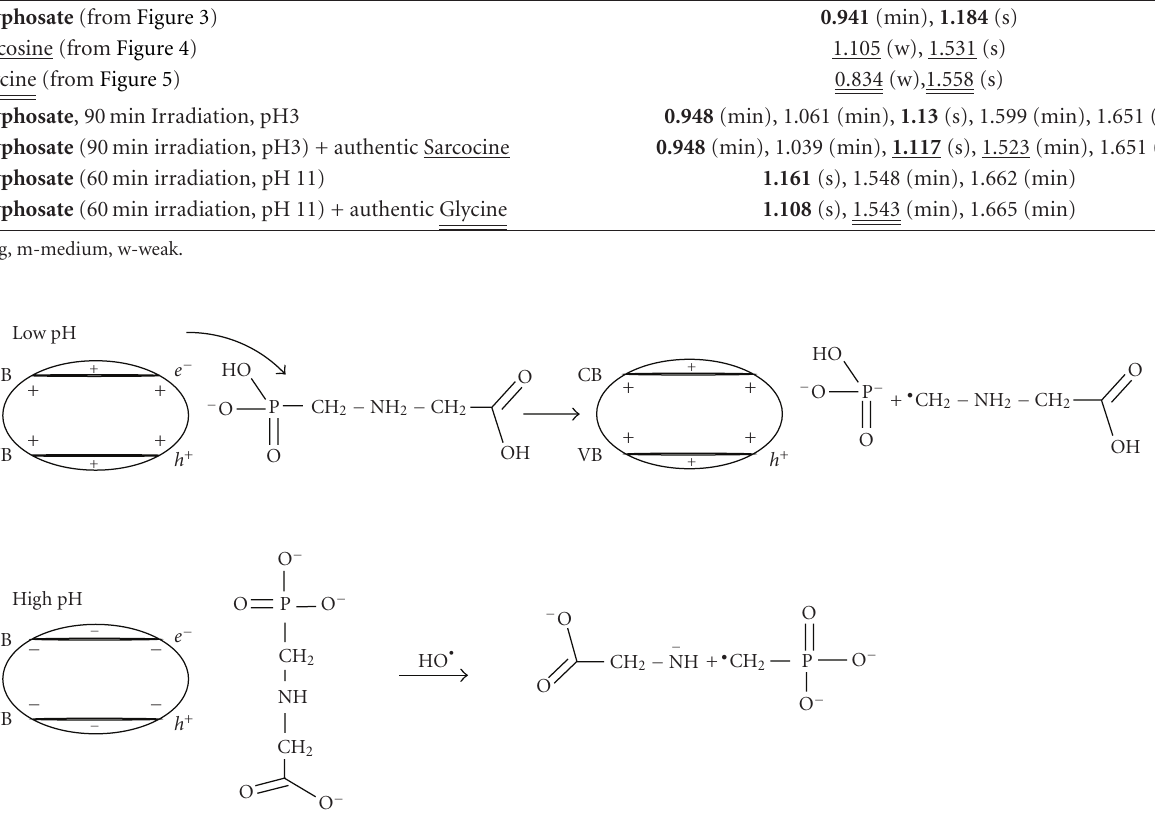
Figure 6: The interaction of glyphosate with the surface of TiO 2 in dark and the subsequent interaction of photogenerated electrons and hydroxyl radicals with glyphosate upon illumination of the TiO 2 with ultraband gap irradiation.